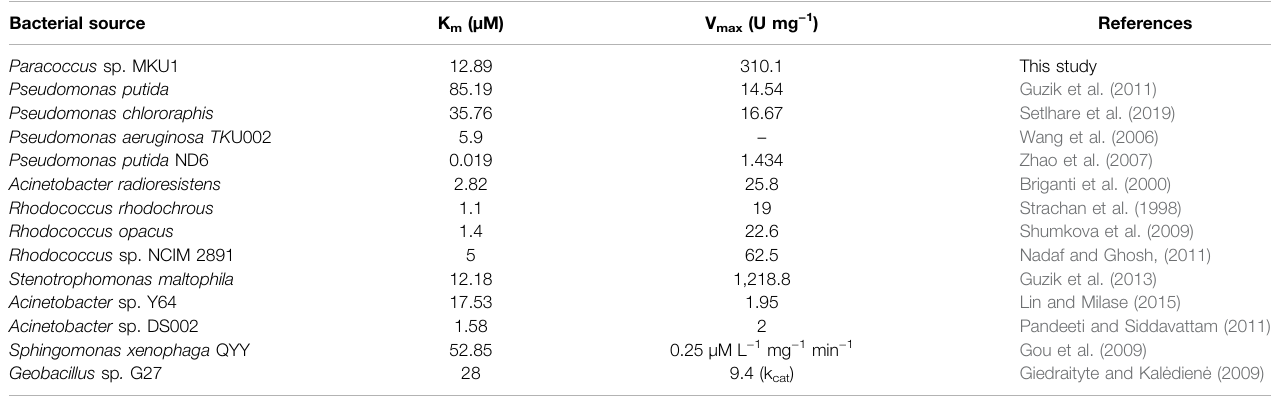
TABLE 1 | Enzyme kinetic parameters K m and V max for Catechol 1,2-dioxygenase from various bacterial sources. Bacterial source K m (µM) Paracoccus sp.